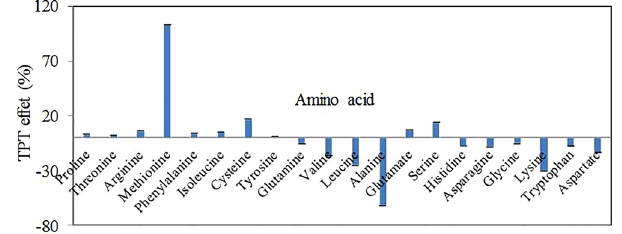
Figure 3. Interaction between TPT and